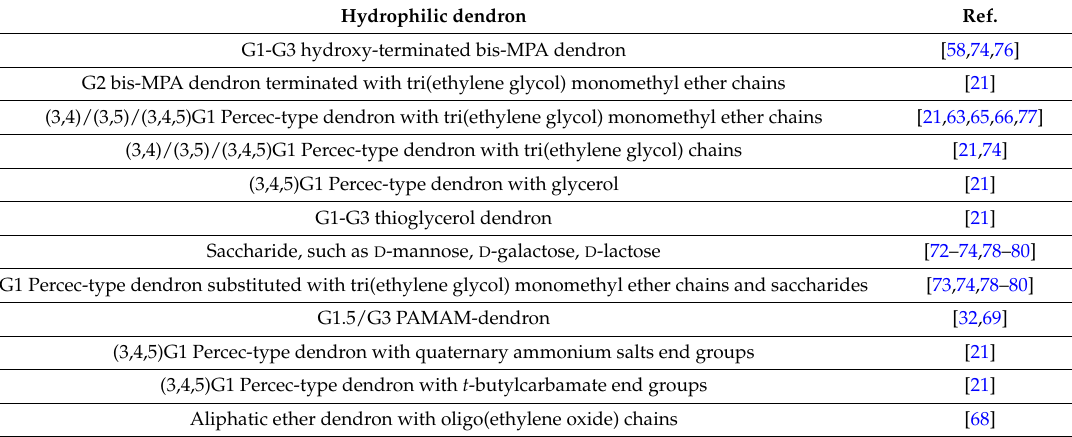
Table 2. Structural features of JDs self-assembling in aqueous environment: hydrophilic